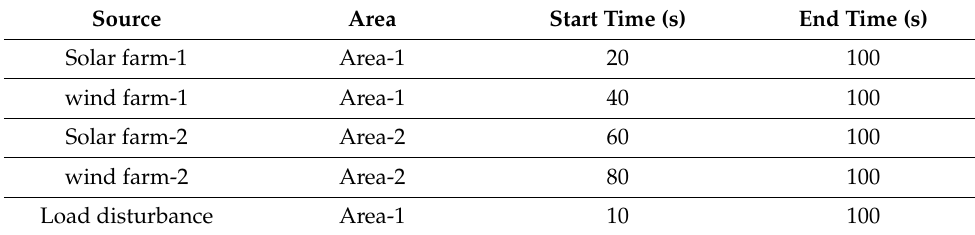
Table 5. The operating conditions of the system under study for scenario